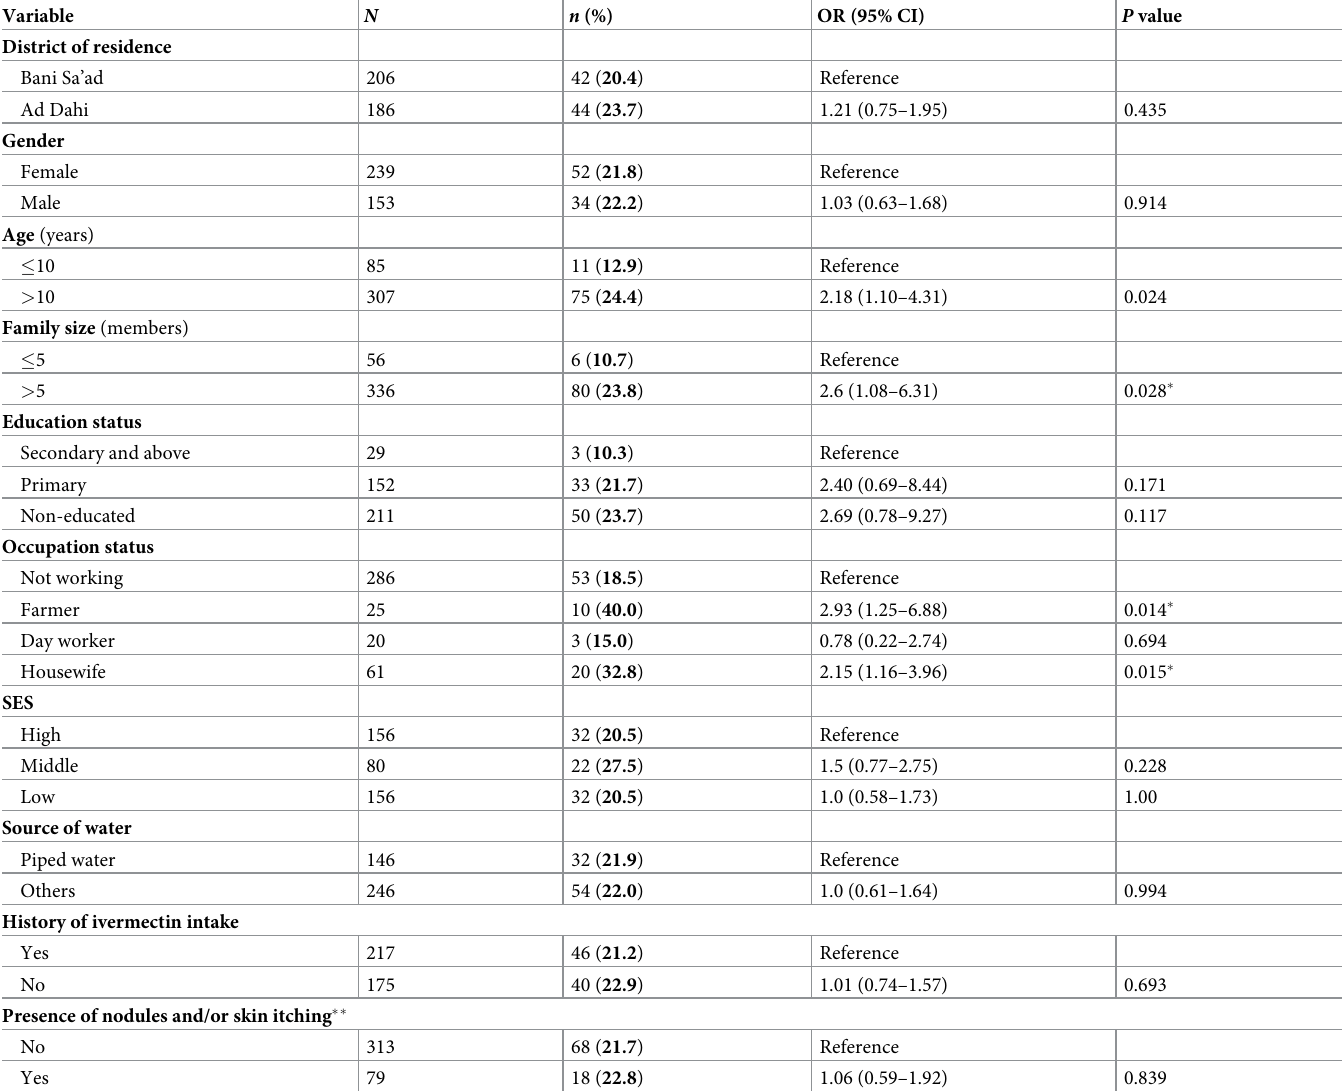
Table 3. Factors associated with anti- Ov 16IgG4 seropositivity among residents of onchocerciasis-endemic areas of Hodeidah and Al-Mahwit, Yemen